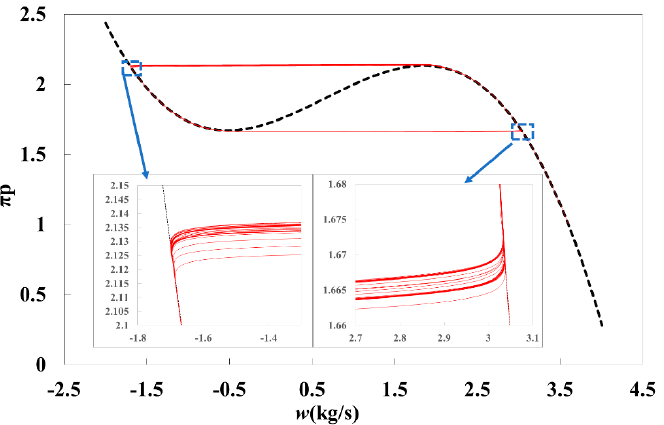
Figure 15. Compressor operating trajectory of the compression system with two throttle valves.